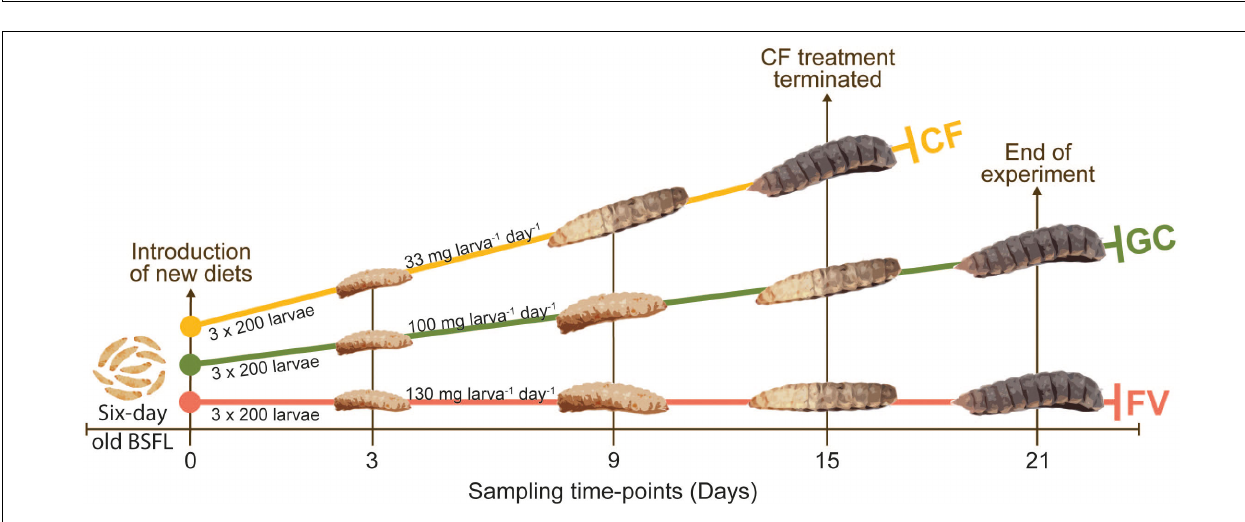
FIGURE 3 | Illustration of the experimental design. Larvae were collectively raised on chickenfeed (CF) for 6 days. At Day 0 , 3 × 200 6-day old larvae were manually counted for each of the three diets and put into separate boxes. The two new diets (GC = grass-cuttings and FV = fruit/vegetable mix) were introduced to a triplicate of boxes each, while one triplicate was further fed with CF as control. The amount of feed per larva and day was adapted based on the respective organic and water content. CF treatment was terminated at Day 15 as all larvae transitioned to prepupal stage. GC and FV treatment further continued until Day 21